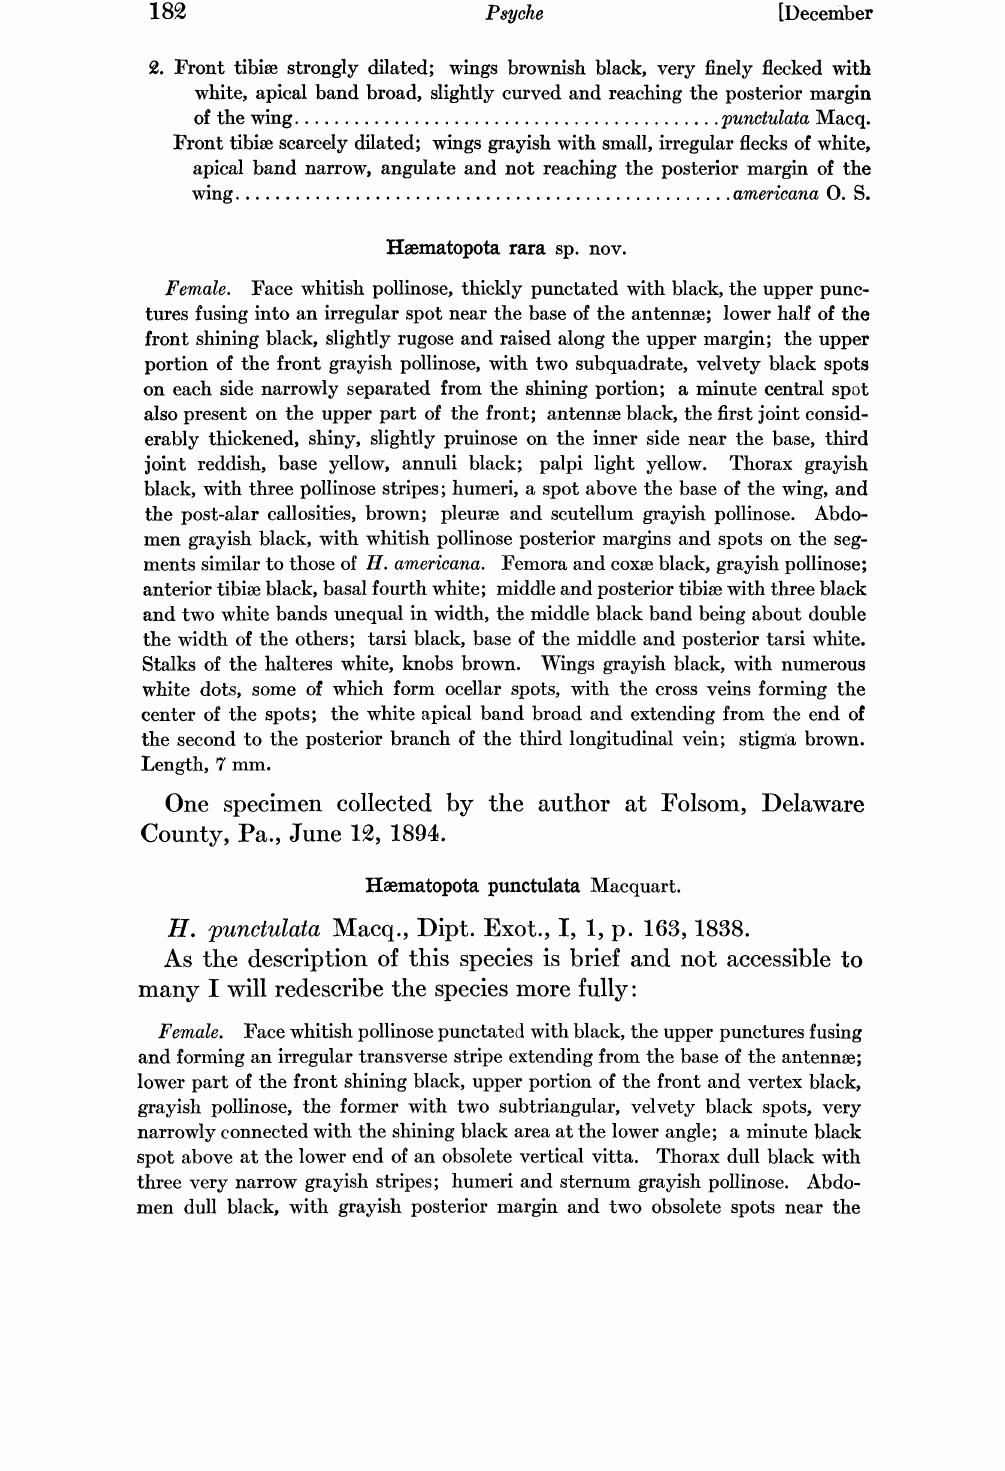
Front tibiae strongly dilated; wings brownish black, very finely flecked with white, apical band broad, slightly curved and reaching the posterior margin of the wing punctulata Macq. Front tibiae scarcely dilated; wings grayish with small, irregular flecks of white, apical band narrow, angulate and not reaching the posterior margin of the wing americana O. S.